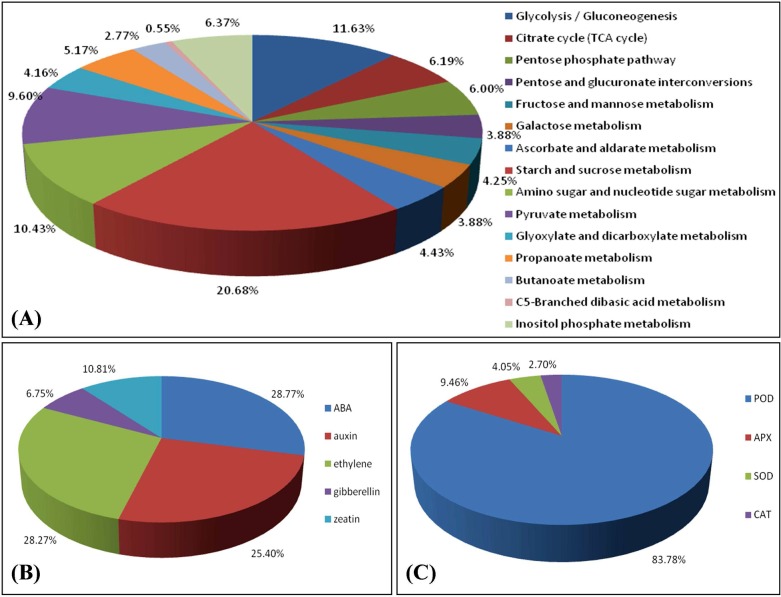
The proportions of sequences related to carbohydrate metabolism, plant hormones and antioxidant enzymes.
(A) The proportion of sequences related to carbohydrate metabolism. (B) The proportion of sequences related to five internal plant hormones. (C) The proportion of sequences related to four antioxidant enzymes.